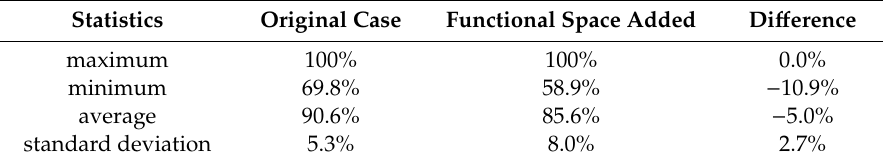
Table 4. Statistics of relative humidity in the tomb chamber.